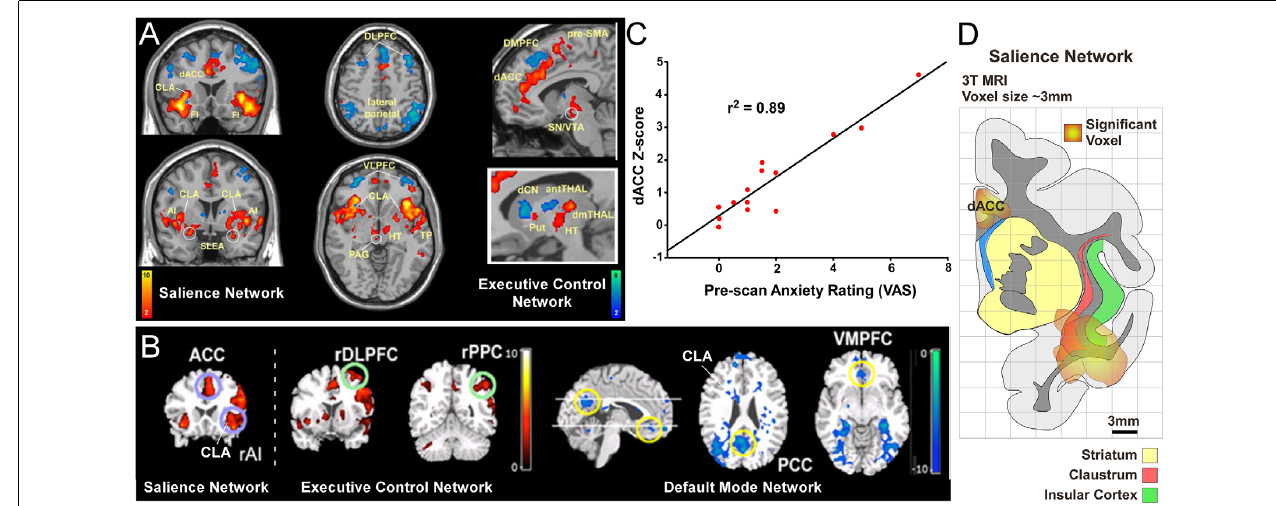
FIGURE 1 | Human functional magnetic resonance imaging (fMRI) studies have identified three distinct intrinsic connectivity networks (ICNs): salience, executive control, and default mode network (DMN). (A) Original human fMRI data identifying the salience network (SN; in hot colors) and the executive control network (ECN; in cool colors). The human SN primarily consists of the dorsal anterior cingulate cortex (dACC), anterior insula (AI), and fronto-insular cortex (FI; Seeley et al., 2007). (B) Graph from the same study showing a strong correlation between a pre-scan diagnostic of the subjects’ anxiety and the strength of connection within the SN. (C) Data from a separate study showing activity in the salience and ECNs (activation strength shown in hot colors), and also the DMN (deactivation strength shown in blue) in response to an auditory event transition. The human DMN primarily consists of connections between ventromedial prefrontal cortex (vmPFC) and posterior cingulate cortex (PCC) that appear as negative correlations when the salience and ECNs are active. (D) Reconstruction of SN activation area from upper left coronal section in panel (A) relative to anatomical boundaries for insula, claustrum and striatum (putamen, caudate, and accumbens). Note the “hotspot” in the insula for the SN encompasses the anatomical region containing the ventral portion of the claustrum (CLA). Panels (A,C) modified with permission from Seeley et al. (2007). Panel (B) modified with permission from Sridharan et al. (2008). Copyright (2008) National Academy of Science, USA.